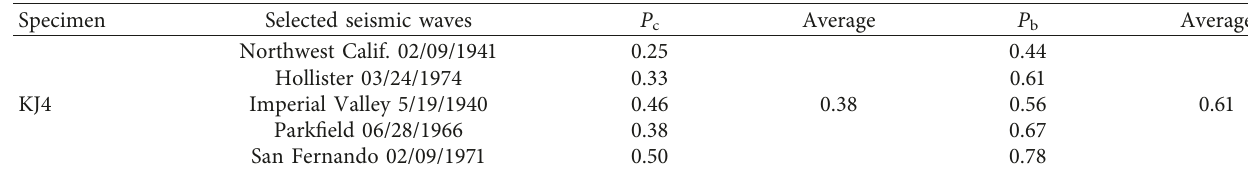
Table 9: Plastic hinge rates of beams and columns in model KJ4.